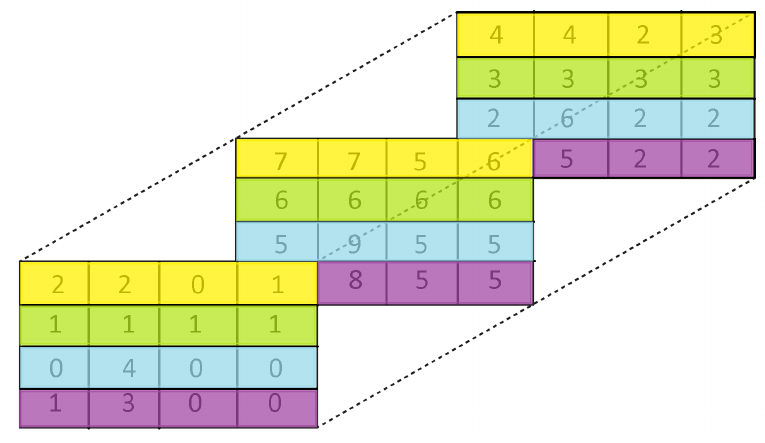
Figure 1. Extension form of the 3D matrix A ∈ R 4 × 4 × 3 of Example